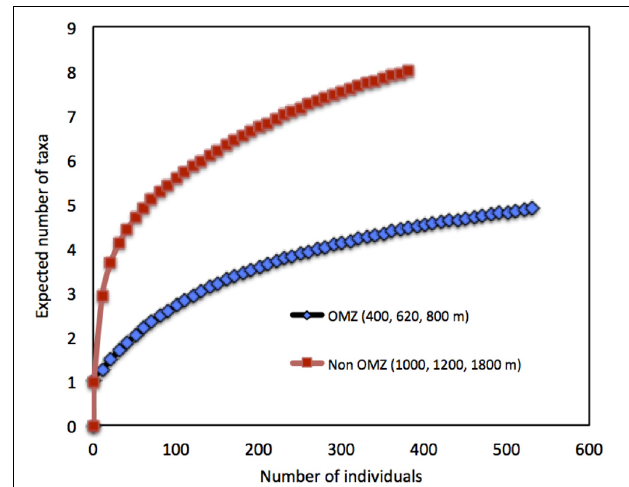
FIGURE 7 | Rarefaction curves depicting diversity of meiofaunal assemblages at sites within the OMZ ( < 0.5 ml L − 1 ; 400, 620, and 800 m) vs. sites beneath the OMZ ( > 0.5 ml L − 1 , 1000, 1200, and 1800 m) off Costa